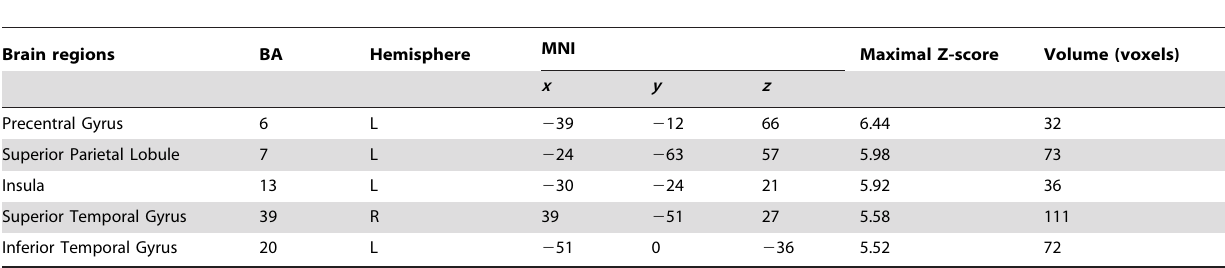
Table 2. Brain areas with significant main effect of group at P , 0.001 (uncorrected, 30 voxels).